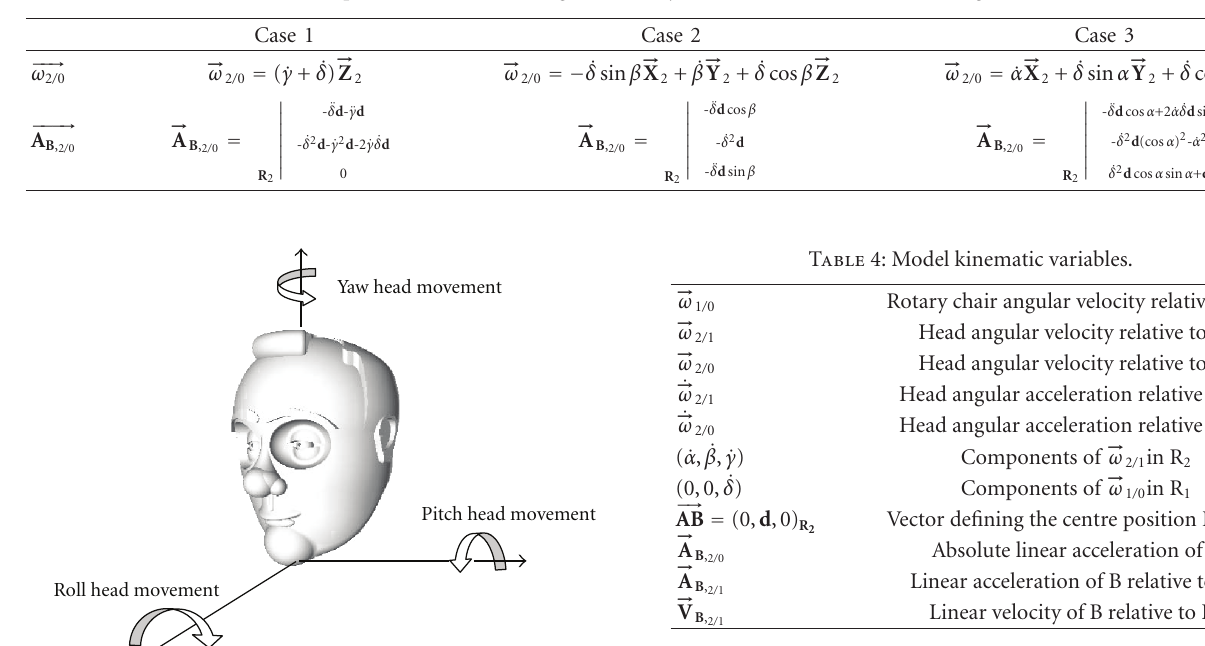
Table 3: Expressions of the head angular velocity and of the acceleration of the origin of R 3 .